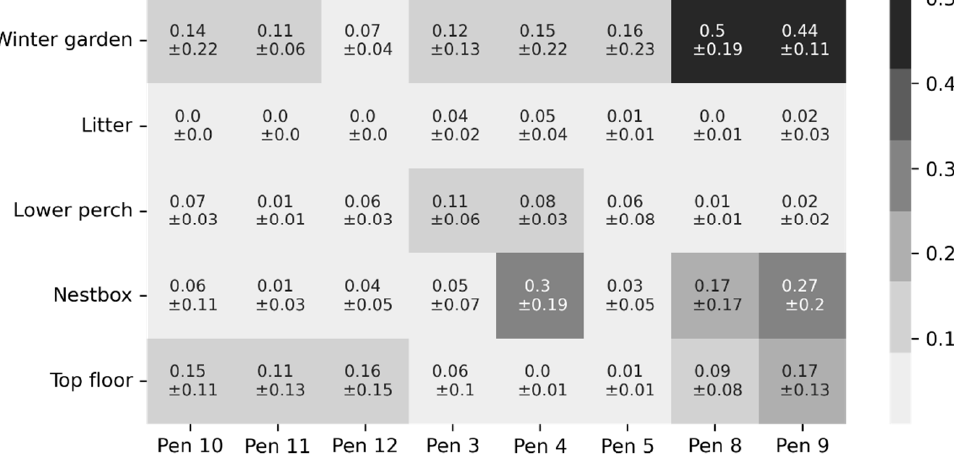
Figure 6. Unprocessed data (yellow) and processed data by the ML method (blue) of a single animal over five consecutive days. Each row represents a single 24-hour day, with the zone identities rep- resented on the y-axis (the indoor zones are ordered following the aviary order, and the winter garden is represented below the indoor zones). 4. Discussion We found the presented LF tracking system accurately determined the presence of animals in a given zone (at the second level), with macro-averaged precision, and macro- averaged recall of 99% when compared against video observations of the test dataset. This good performance might be explained by the tag algorithm, which searches for new tran- sitions, on average, every 0.5 s (i.e., each time a tag receives an LF signal), thus regularly providing opportunities for correctional records. However, the number of transitions in a zone generated by the tracking system was overestimated and only explained 23% of the true variance (as observed by video). Therefore, the unprocessed tracking data did not constitute a good representation of individual transitions between the five zones, which could be emphasized by the observed differences in the estimated error rate within spe- cific pen-zone areas. On the one hand, we observed clear differences in the estimated error